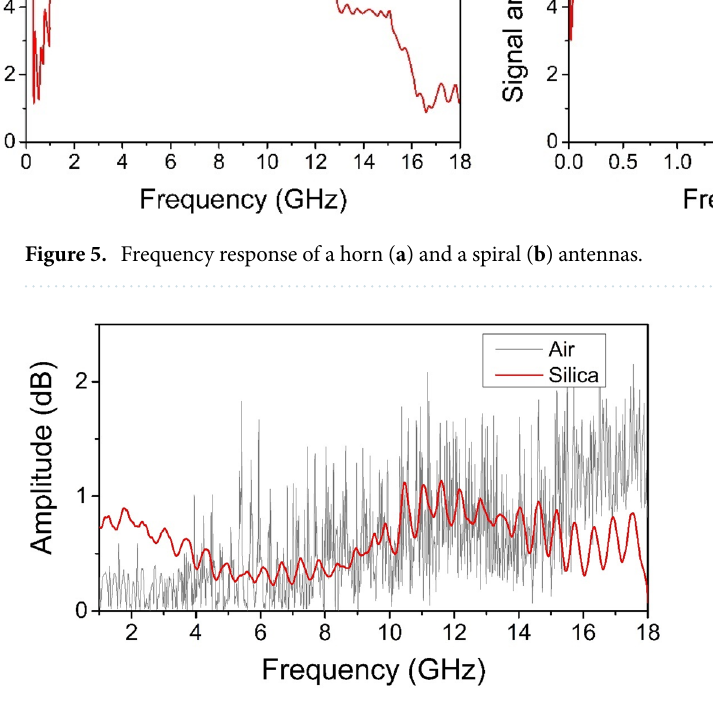
Figure 6. Typical EM emission power spectra registered by a wideband horn antenna in the case of laser breakdown in air and quartz